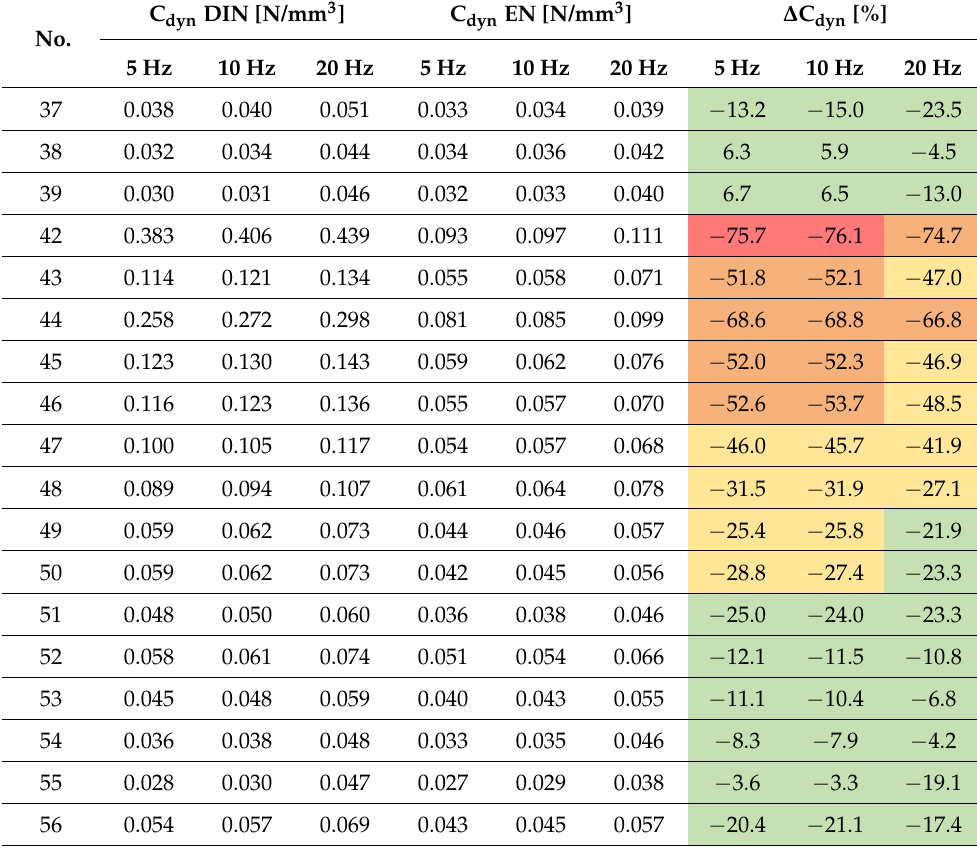
Table 9. Dynamic bedding moduli in low frequencies of UBM according to DIN [23] and EN [24].